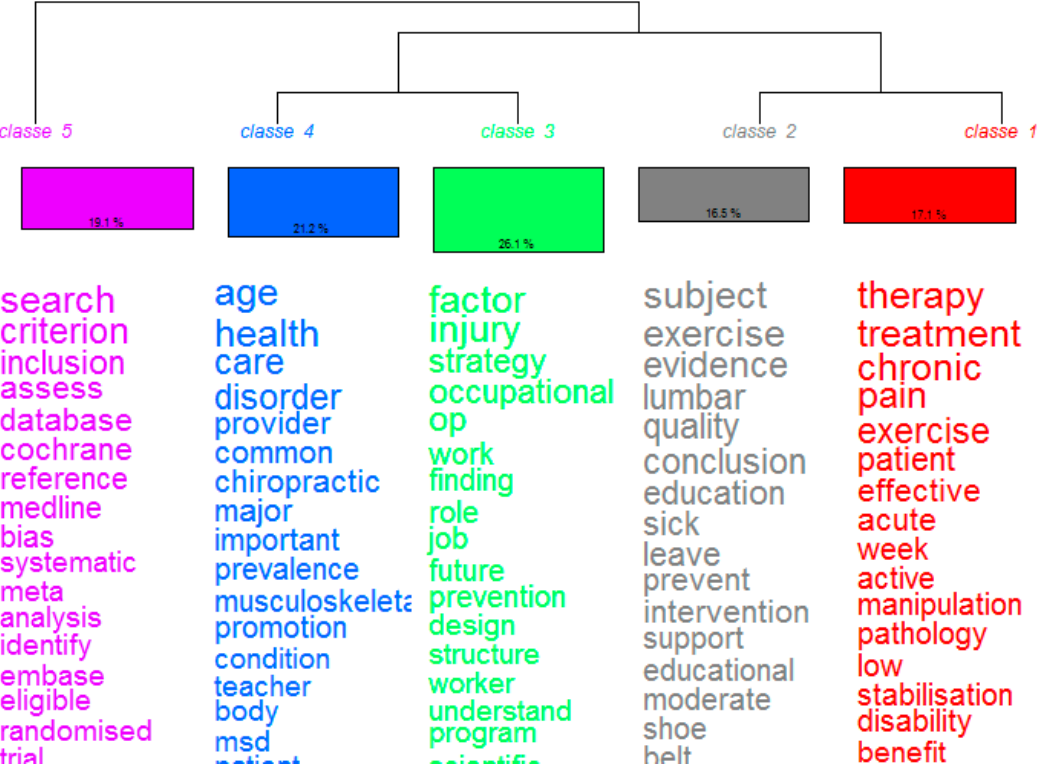
Figure 12. SRL in health sciences (low back pain prevention) using Reinert’s